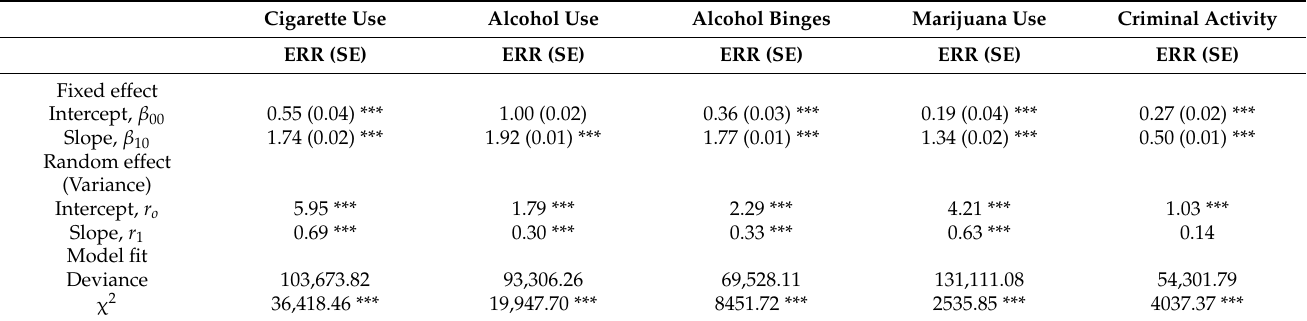
Table 3. Unconditional growth models (Model